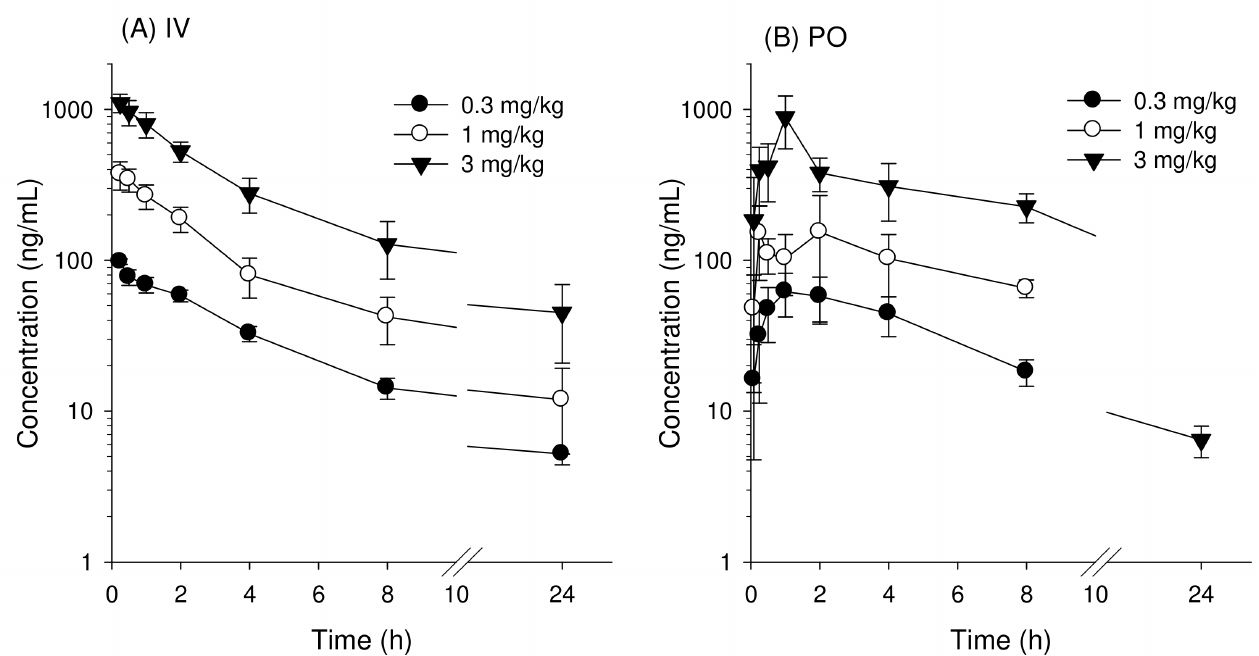
Figure 2. Plasma concentration vs. time profile of enavogliflozin in mice after ( A ) single intravenous (IV) injection of enavogliflozin at doses of 0.3, 1, and 3 mg/kg and ( B ) single oral administration (PO) of enavogliflozin at doses of 0.3, 1, and 3 mg/kg. Data represented as the mean ± standard deviation (n = 6 for each